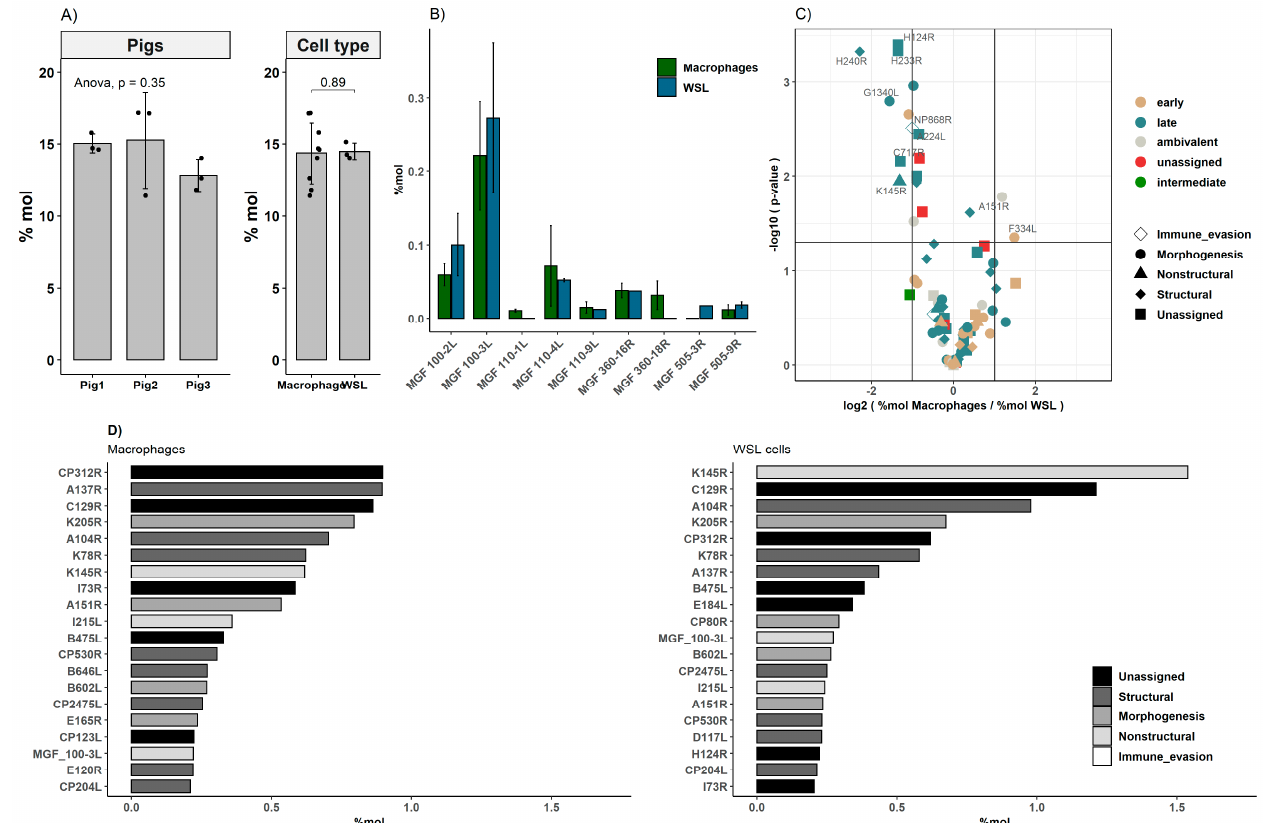
Figure 5. Expression of viral proteins in moM Φ and WSL cells. ( A ) Quantitative analysis of viral protein expression as proportion of whole proteome. ( B ) Expression of MGF members. ( C ) Volcano plot representing differential expression of proteins belonging to different functional group and kinetic classes, the horizontal line corresponds to p = 0.05 (two-sided t-test), vertical lines to fold-changes of 2 and 0.5, respectively, n(moM Φ ) = 9, n(WSL) = 3. ( D ) Mean expression levels in mole percent (%mol) of most abundantly expressed viral proteins in moM Φ and WSL cells.